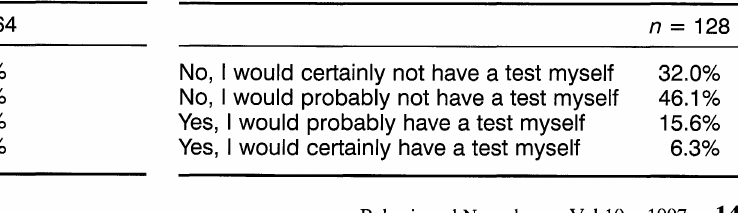
Totally unimportant